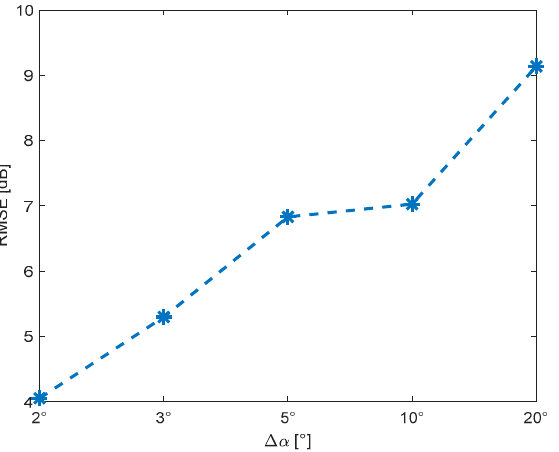
Figure 15. RMSE of attenuation error for selected angular resolution of terrain profiles.